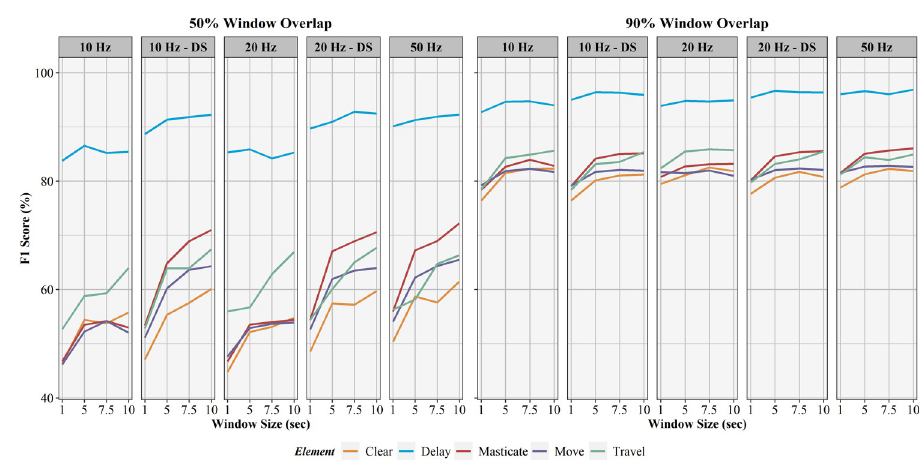
Fig 9. F1-score results for activity recognition models. Comparison of activity recognition model F1-score percentages for 50% and 90% sliding window overlaps across the four sliding window lengths (1, 5, 7.5, 10 seconds) for each work element (clear, delay, masticate, move,